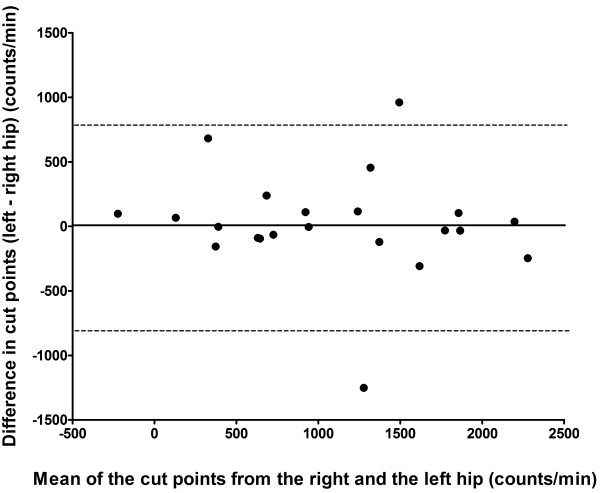
Bland-Altman plot of cut points obtained from the right vs. the left hip. Dotted lines are 95% limits of agreement.